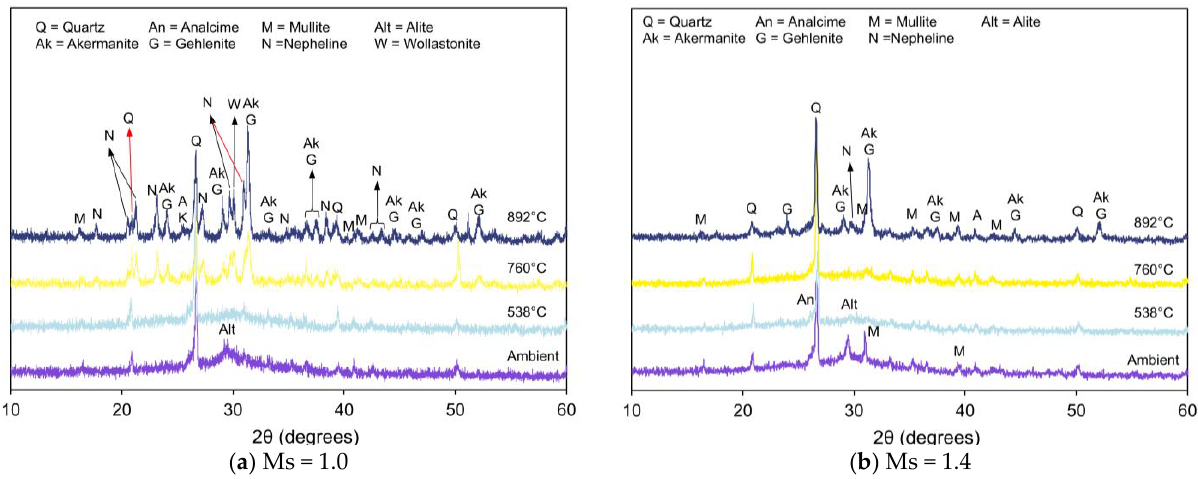
Figure 8. XRD pattern of FS 50P on exposure to elevated temperature.